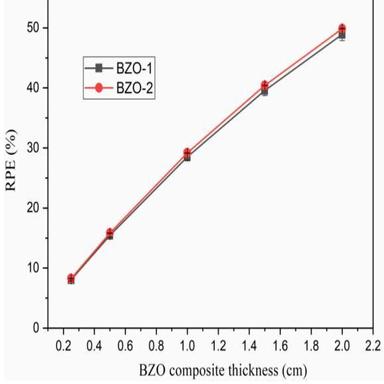
Dependence the RPE (%) on the fabricated BZO composite thickness (cm).